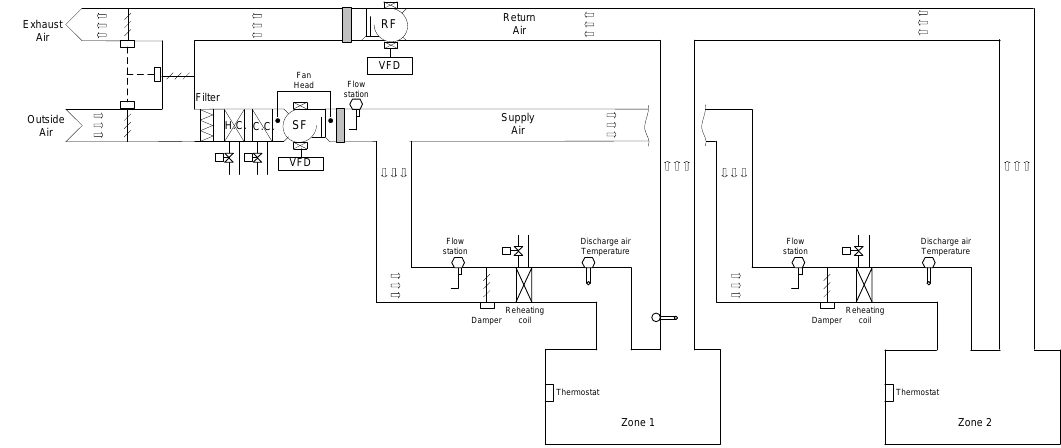
Figure 1. Schematic diagram of experimental system.